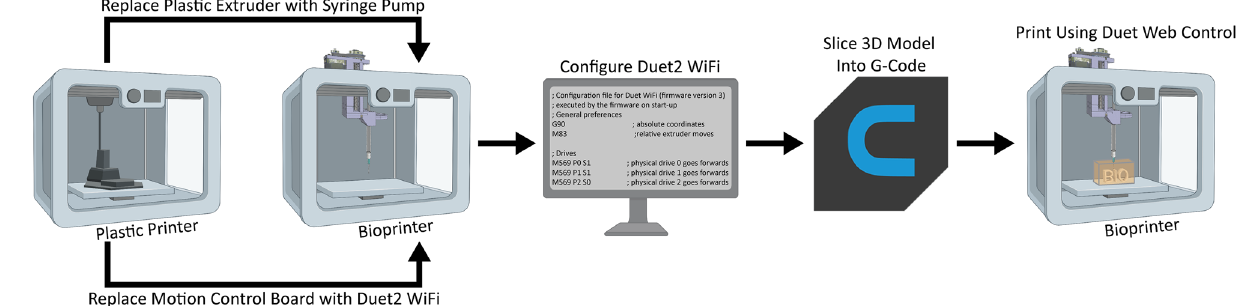
Figure 1. Steps in converting a plastic printer to a bioprinter. The plastic extruder printhead and the motion control board of the plastic printer are switched to a syringe pump extruder and Duet2 WiFi control board, respectively. The Duet2 WiFi is then configured to run a bioprinter. To bioprint, the desired 3D model is sliced into machine pathing (G-code generated with Cura Ultimaker software) and then Duet Web Control executes the print using the desired bioink. Figure created in part with